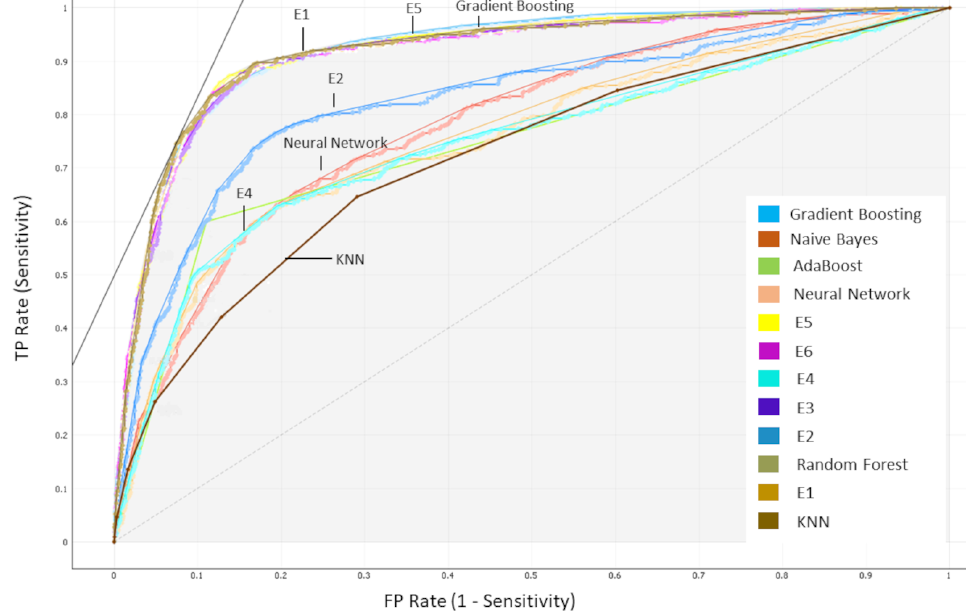
Figure 11. AUC-ROC curves comparison based on information gain sets. Table 7. Detailed results of model evaluation using 24 h of look back data and 1, 2, and 3 h prediction